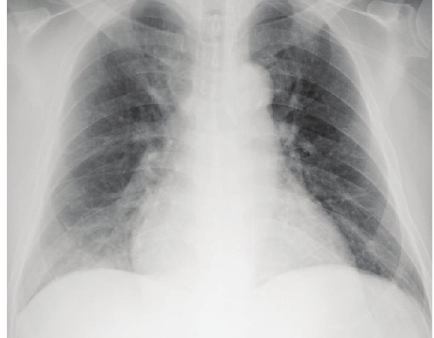
Figure 1: Chest X-ray shows cardiomegaly and pulmonary vascular congestion.